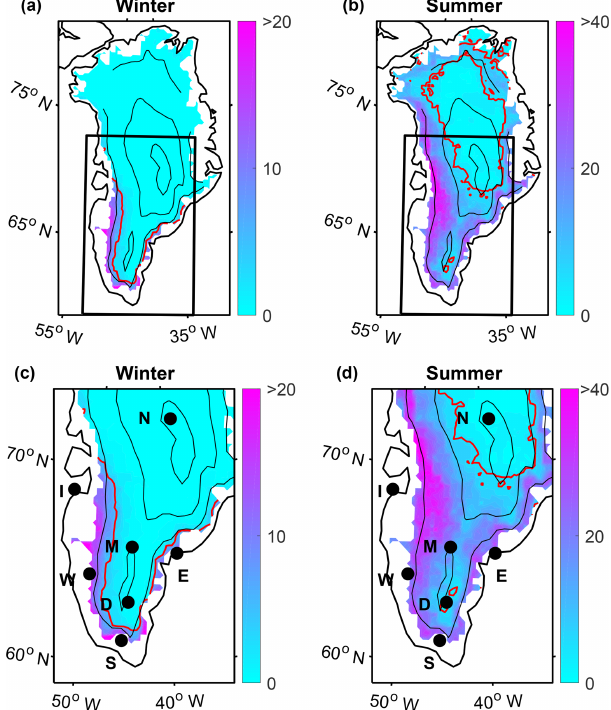
Figure 2. (a, b) Percentage of the events with fresh melt on day 1 relative to day − 1 (Fig. 1d). Red contours mark the 5% thresh- old and black contours delineate the elevation of the ice sheet at 1600, 2600 and 3100m height. (c, d) Same as in (a, b) , focusing on southern Greenland. Black circles indicate the locations of stations Summit (N), NW (I – on a small island), South (S), East (E), West (W), SD (D) and Saddle